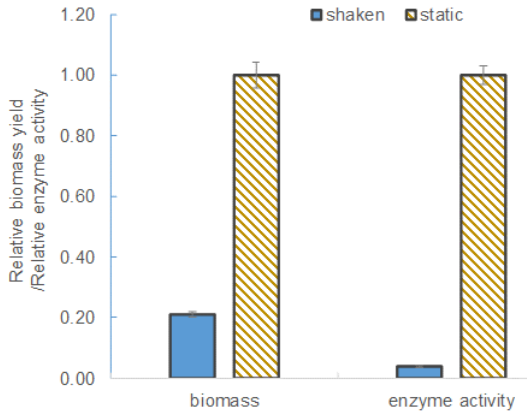
Figure 2. The biomass yield and enzyme activity in shaken and static cultures. The bacteria were grown for 12 h at 37 ◦ C in 20 mL of modified MRS broth placed in 30 mL capacity universal media glass bottles. The agitation speed was 100 rpm in a shaken culture condition. Results are shown as the mean standard deviation of three independent experiments, and normalized to ±